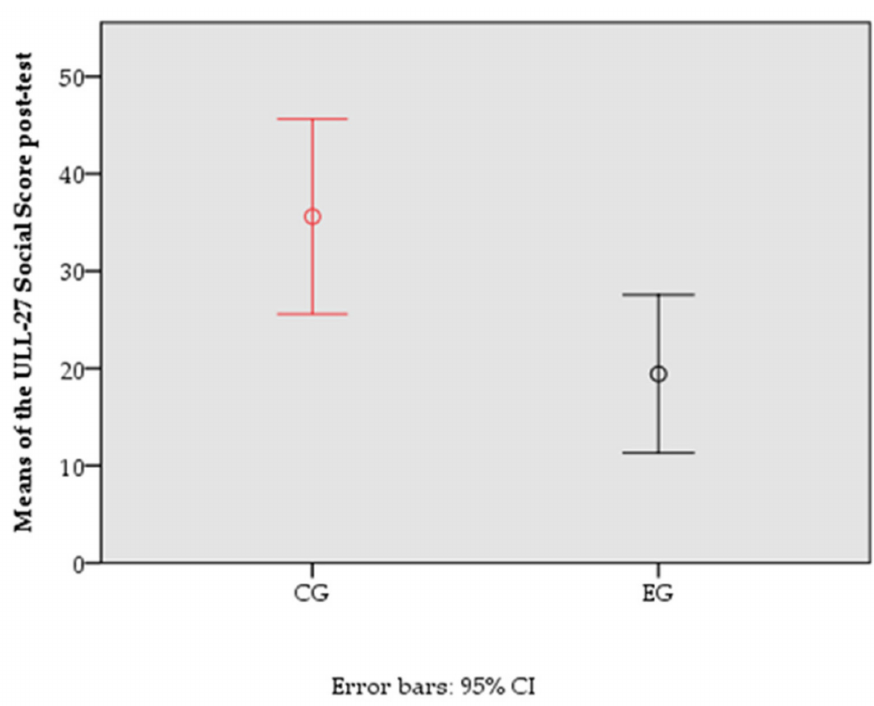
Figure 3. Means of the ULL-27 Social Score of the different groups in the